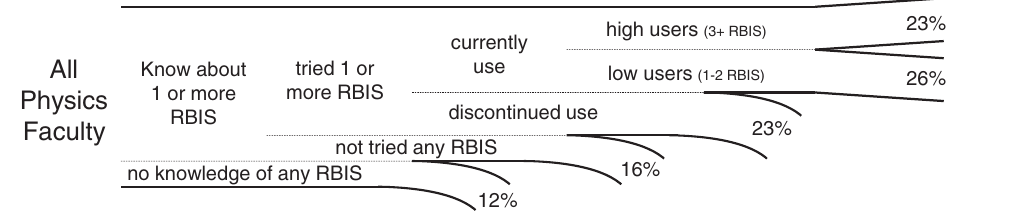
FIG. 1. Where do faculty leave the innovation-decision process?